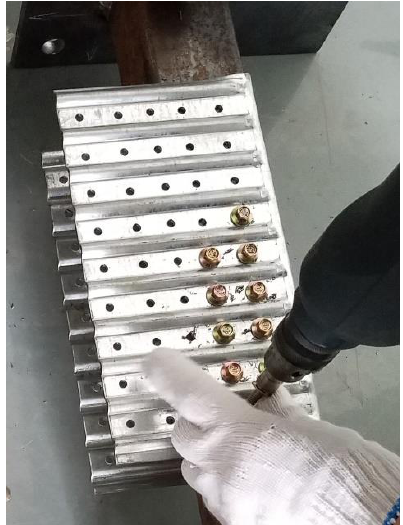
Figure 5. Connection between the U-shape connector and the chord.